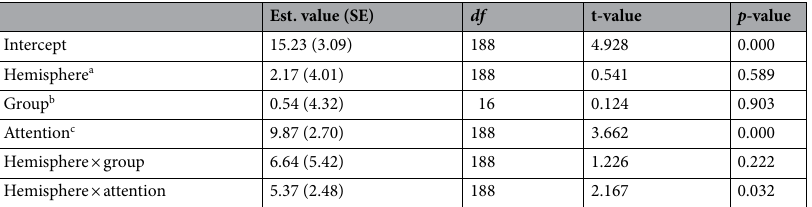
Table 3. Fixed effects of the model for the second time window: estimate (SE), degrees of freedom, t-value, and p -value. a Baseline for hemisphere: right, b baseline for group: DLD, and c baseline for attention: passive.